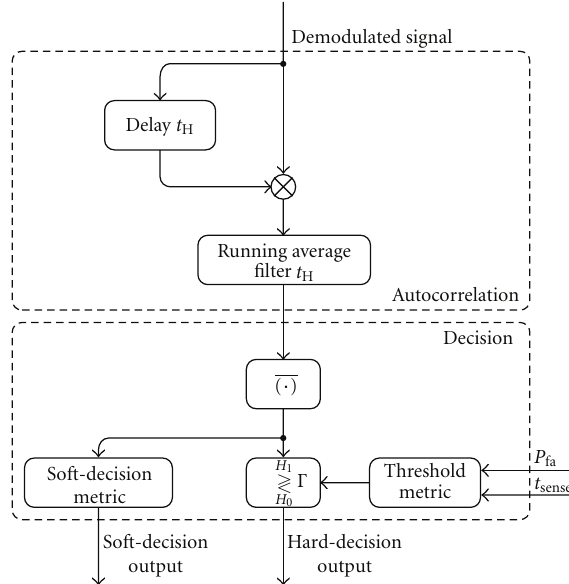
Figure 7: Flow diagram of the PAL-D/K sensing